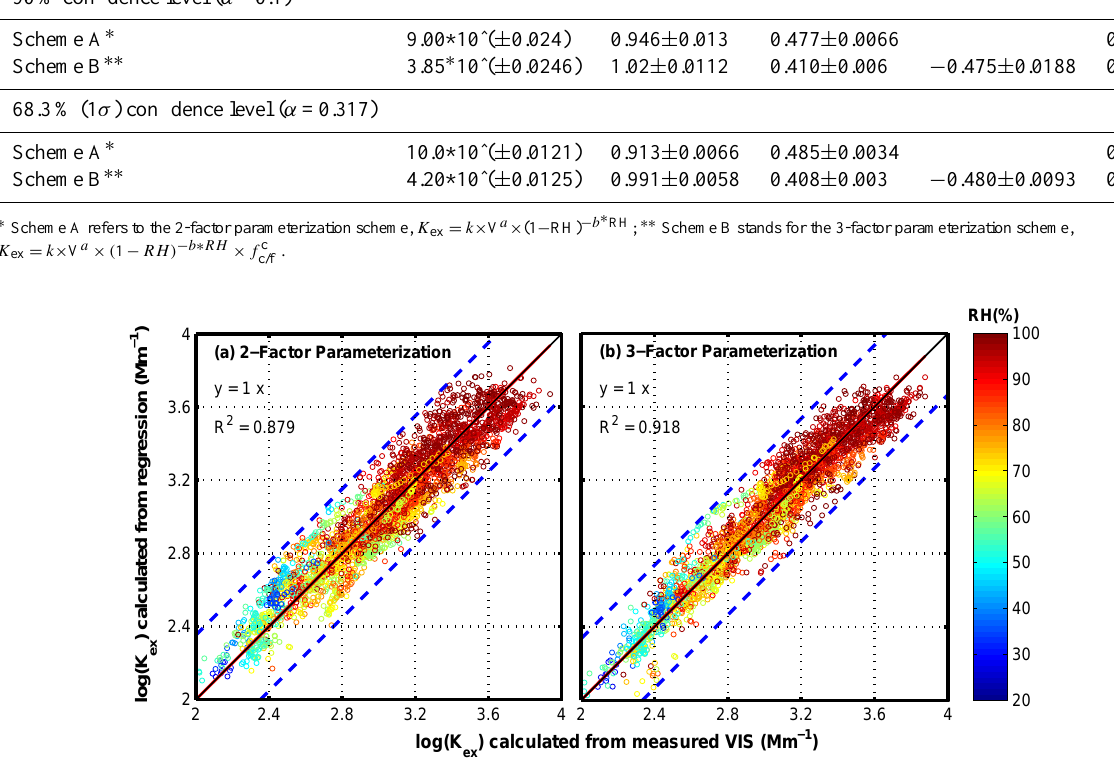
Fig. 7. Comparison results of ten-minute average K ex between calculated from regression equations and measured visibilities, with (a) 2- factor parameterization and (b) 3-factor parameterization (both at 95% confidence level); the colored circles stand for the corresponding RHs, which increase with color from blue to